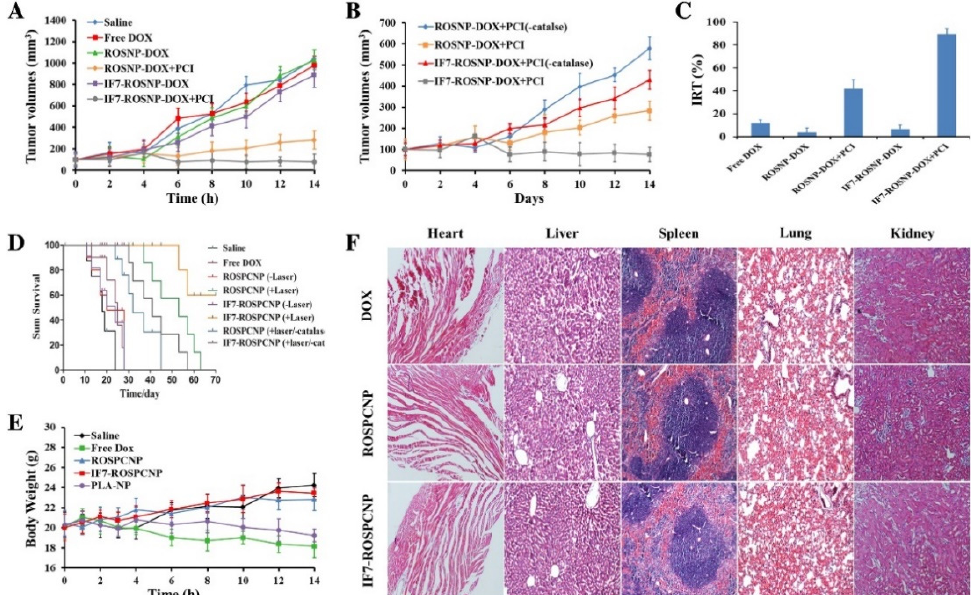
Figure 5. Evaluation of animal studies treated with several samples, such as free DOX, ROSPCNP and IF7-ROSPCNP, in the presence or absence of laser irradiation. ( A , B ) Evolution of tumor volume, ( C ) relative inhibition rate of tumor (IRT), ( D ) survival of the animals along the days of the experiment, ( E ) evolution of body weight and ( F ) histopathological analysis of heart, liver, spleen, lung and kidney of animals treated with different approaches (reproduced from Reference [78] with permission from Elsevier. Copyright 2019. Nanomedicine: Nanotechnology, Biology and Medicine).